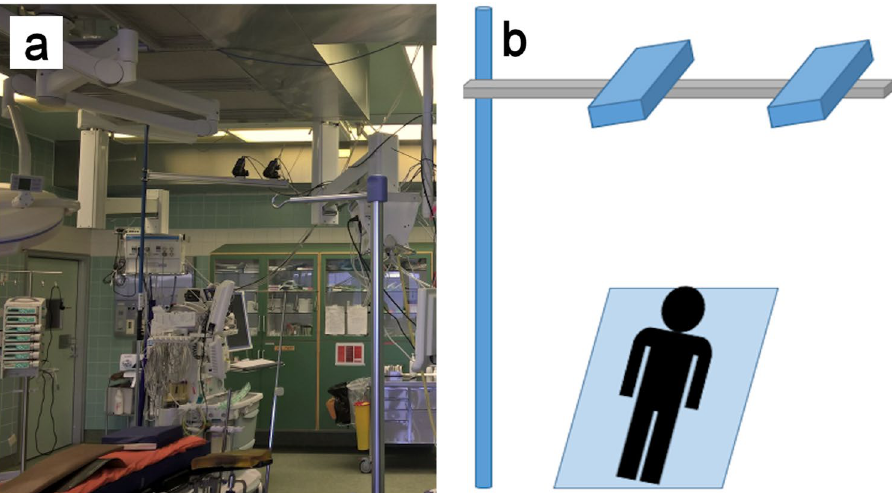
Figure 1. ( a ) Picture of the DIC setup installed in the surgery room, ( b ) Schematic picture of the DIC setup.